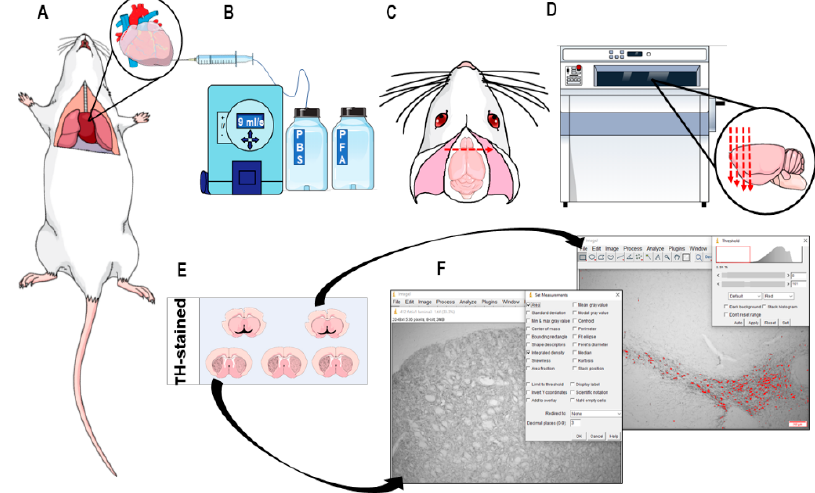
Figure 3. Representative schematic of the major experimental steps to assess nigrostriatal dopaminergic death. ( A ) Transcardiac perfusion: animal with exposed rib cage. The insert shows the heart with a cut in the right atrium for drainage of infused solutions, represented by the red line, and needle in the left ventricle for the entrance of the perfusion solutions. ( B ) Infusion pump set to move 9 mL/s to deliver phosphate buffered saline (PBS) solution and then paraformaldehyde (PFA). ( C ) The skullcap was removed for exposure and removal of the brain. ( D ) Brain was coronally sliced in a cryostat at 40 µm under a temperature of − 24 °C. ( E ) Representative image of the positive TH-stained slices after immunohistochemistry protocol. ( F ) Quantification of the percentage of dopaminergic death in striatum and in substantia nigra pars compacta (SNc) using Image J software.